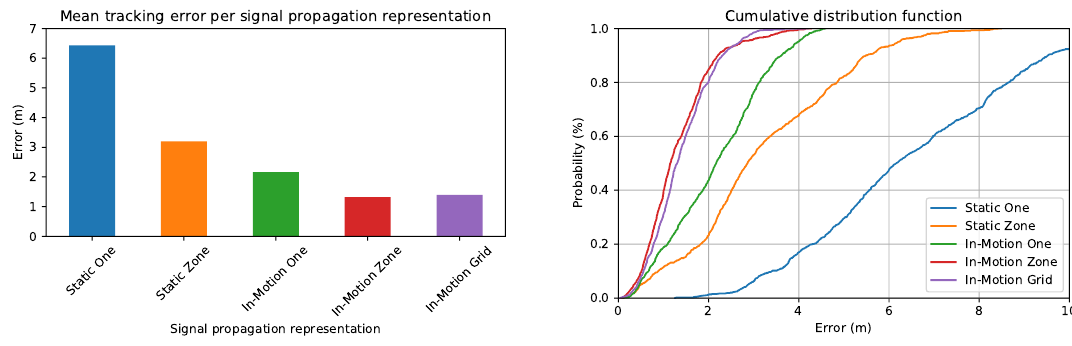
Figure 11. Tracking accuracy per signal propagation representation: mean error ( left ) and cummulative distribution function ( right